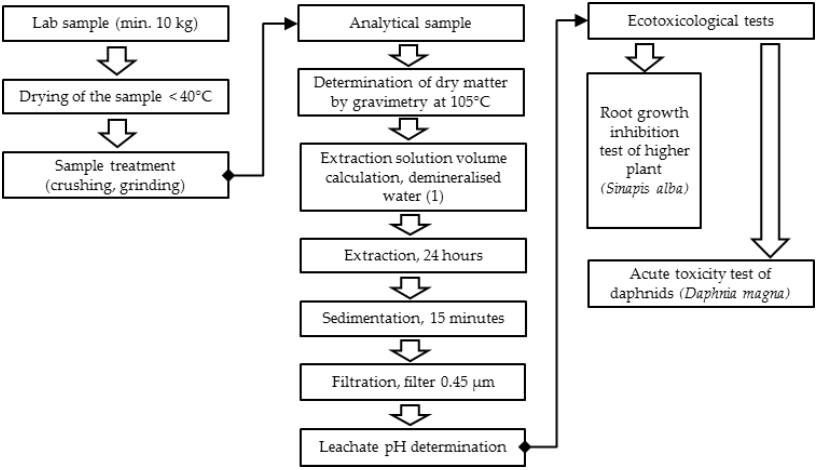
Figure 2. The treatment process of the concrete composites sample from the strength tests and the water leachate preparation [19].